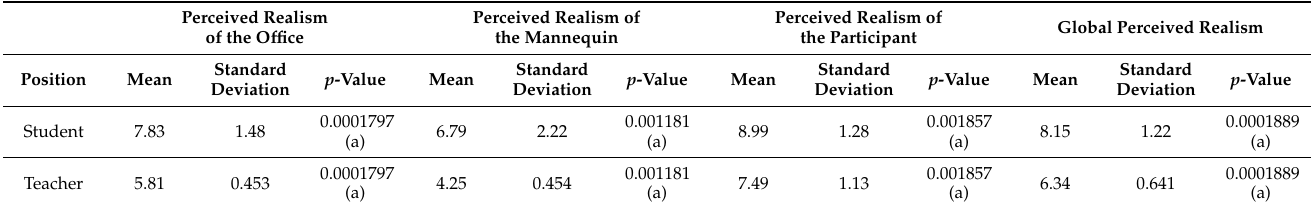
Table 4. Realism as perceived by students and teachers.